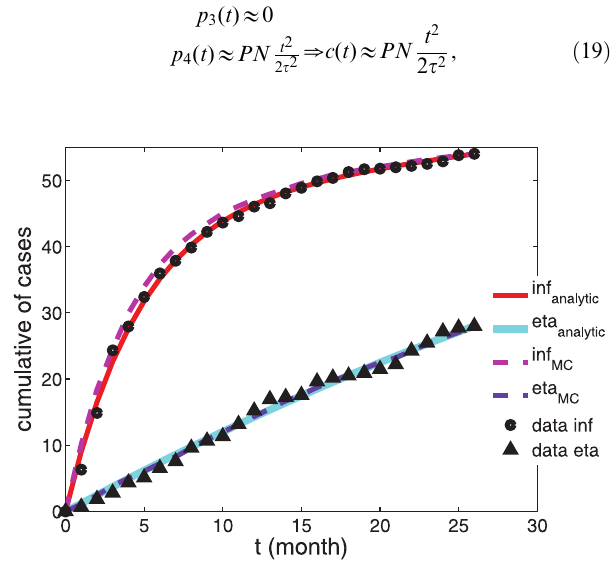
Figure 3. Comparison between experimental, analytical and numerical results for the TB-infection case. Cumulative number of patients undergoing active TB-infection. Experimental data from [9] ( . for infliximab-treated patients and D for etanercept-treated patients) are compared with the approximated analytical solution (see Eq. 15 and Eq. 16, respectively, solid curves) and with data from numerical simulation (dashed curves). The parameters used to draw the analytical curves correspond to the best-fit coefficients and are reported in Table 1. Notice that here we consider the extensive number of patients affected by TB over a population of N ~ 10 5 treated patients, according to experimental results.